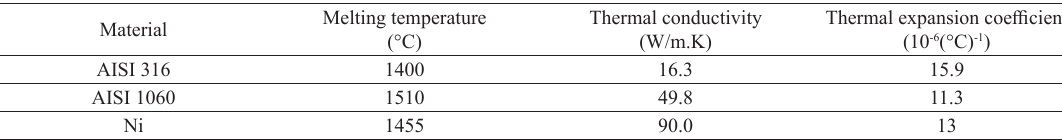
Table 2. Chemical composition of the materials used in this study. Base metal